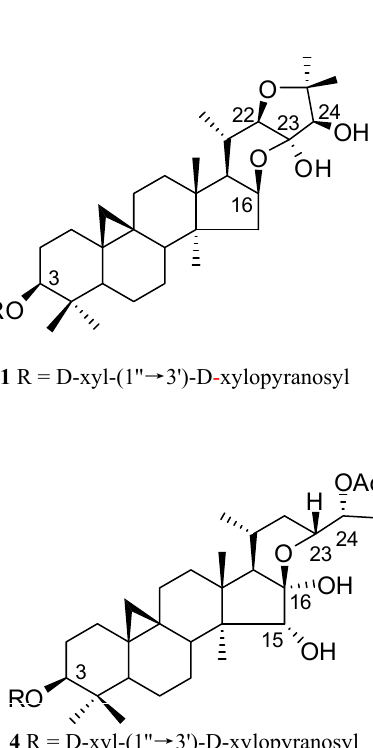
Figure 1 . Structures of triterpenoid diglycoside from the C.